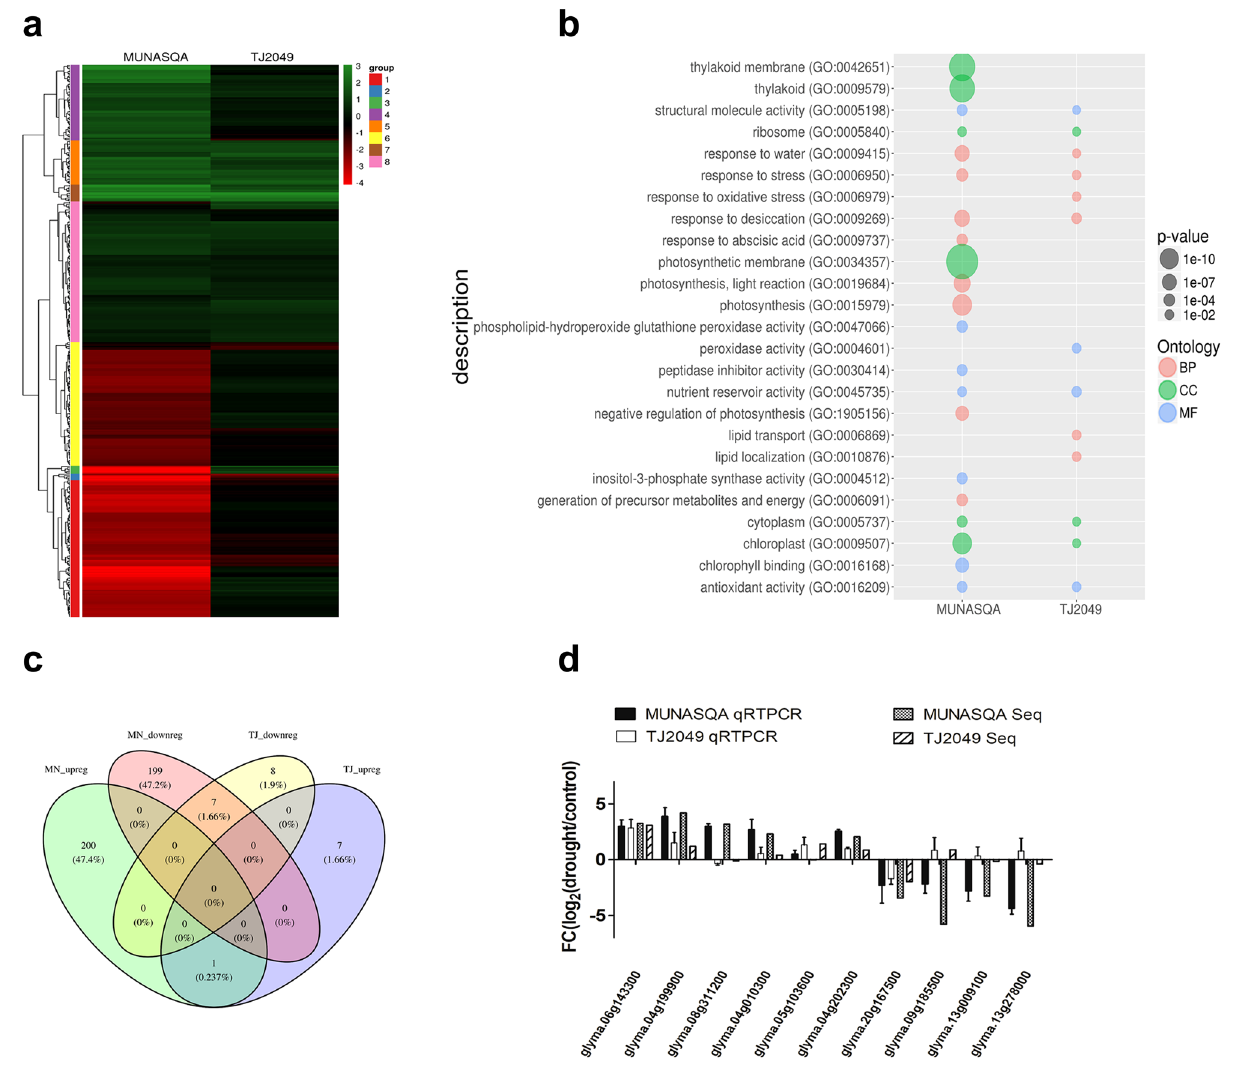
Figure 1. Transcriptomic analysis of MUNASQA and TJ2049 genotypes under drought. Heat-map of all DEGs for MUNASQA and TJ2049 in drought conditions. Scale color indicates green for up-regulation and red for downregulation ( a ). GO enrichment in MUNASQA and TJ2049 comprises biological processes (BP, in red), molecular function (MF, in blue), and cellular component (CC in green). Relevant categories showing enrichment of DEGs for both genotypes are depicted. GO terms were plotted after applying an FDR = 0.1 Bubble size correlates with enrichment factor values; for each bubble size, the P-value is indicated ( b ). Venn diagram for all DEGs in MUNASQA and TJ2049 under drought conditions. DEGs were plotted after applying an FDR = 0.1 ( c ). Validation by qRT-PCR of ten genes selected from RNA-Seq. Log 2 fold change (log2FC) was calculated based on the comparison of drought vs control for each genotype ( d ). Three biological replicates were used, and the experiment was performed twice with similar